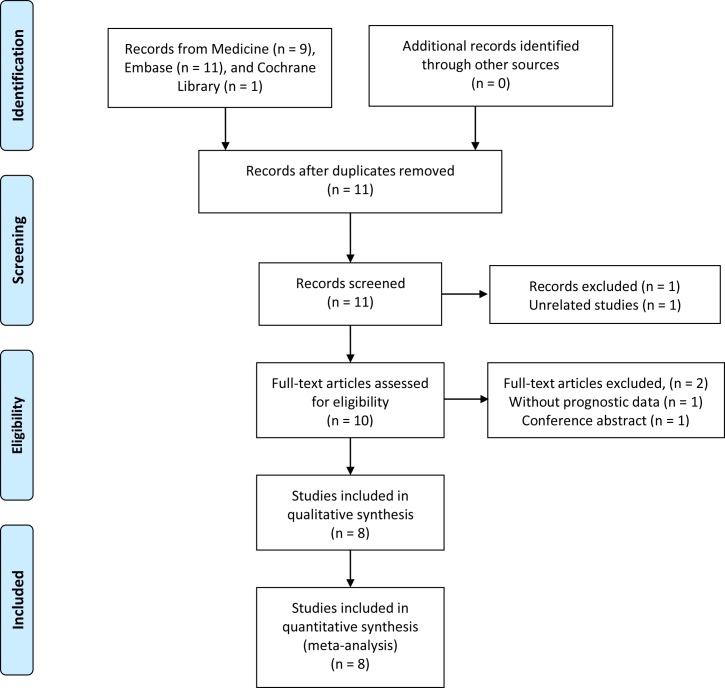
Flowchart describing the literature search and study selection.